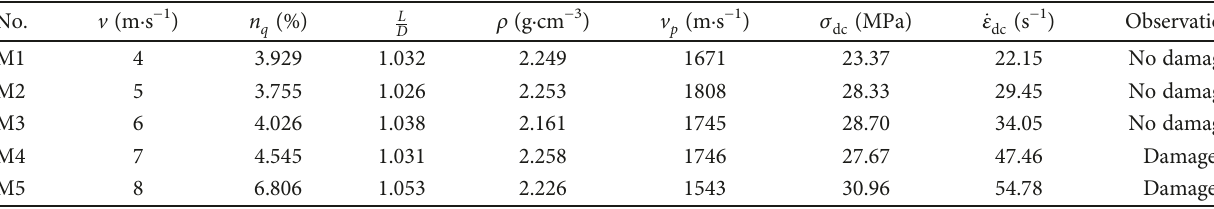
Table 2: Single impact at di ff erent impact speeds.